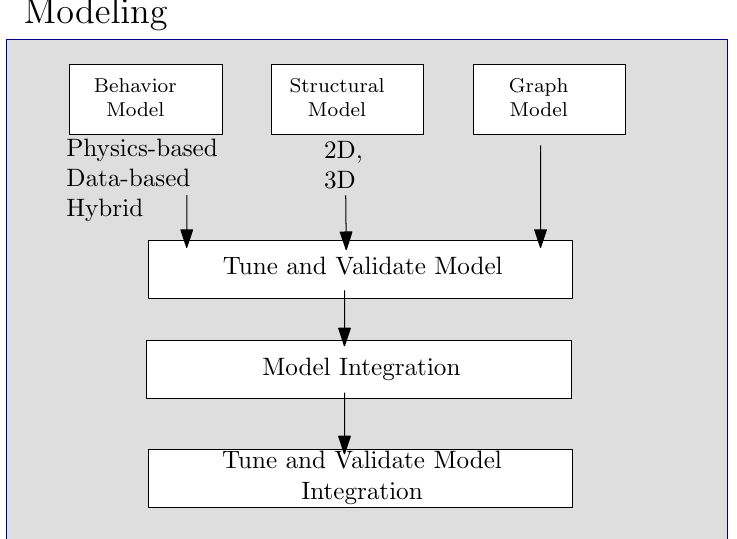
Figure 3. DT modeling